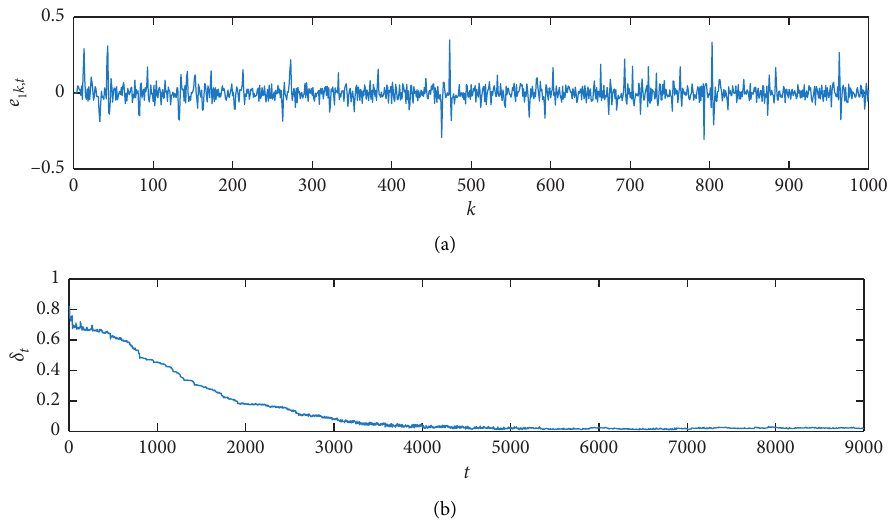
Figure 5: Evolution curves of estimation error (a) and parametric error (b) for the FSOEAHW model using IBPG